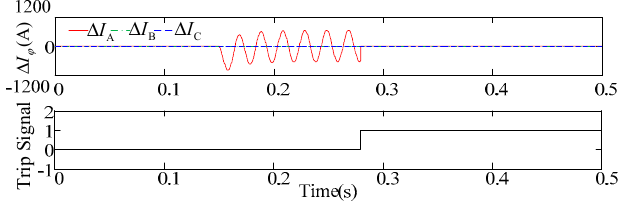
Figure 11. Experimental prototype of wireless sensor devices. ( a ) wireless sensor node in shell; and ( b ) and printed circuit board (PCB) design of wireless sensor module.